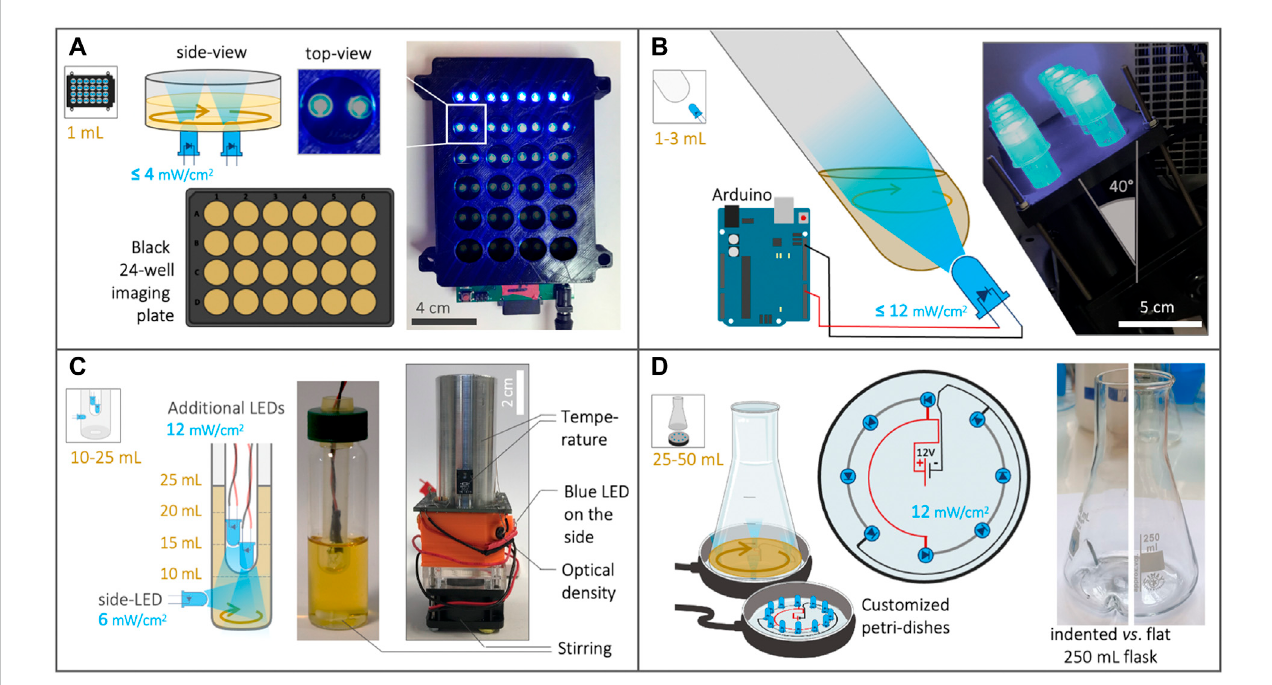
FIGURE 1 Description of the four optogenetic devices used in this study. (A) The OptoBox (adapted from Gerhardt et al., 2016) can independently illuminate 1 mL cultures in a 24-well plate placed in a shaking incubator. Two LEDs (0 – 4 mW/cm 2 ) illuminate each well from below and can be programmed. (B) The OptoTubes are used to illuminate 14 mL tubes (generally 3 mL cultures) using a LED (0 – 12 mW/cm 2 ) placed at the bottom of each tube. The OptoTubes can be programmed with an Arduino (0 – 255 u.a.) and be placed in a shaking incubator thanks to a dedicated 3D printed opaque holder. (C) The eVOLVER culture platform adapted from Wong et al., 2018 uses a DIY “ sleeve ” (right) where a glass vial (center) can be inserted, all connected to an Arduino. We built 16 of these units, and the temperature, stirring and illumination ( via an additional side-LED: 6 mW/cm 2 ) can be controlled for each unit, while the growth rate and production of beta-carotene can be monitored. The lid of the glass vial was adapted to accommodate the input of more light using additional LEDs (12 mW/cm 2 each). (D) The OptoFlasks, in which custom-made illuminationstands werebuilt to holddifferent numbers of LEDs(12 mW/cm 2 each), on top of which the fl asks (indented/baf fl ed or fl at) are positioned and can hold 25 – 50 mL